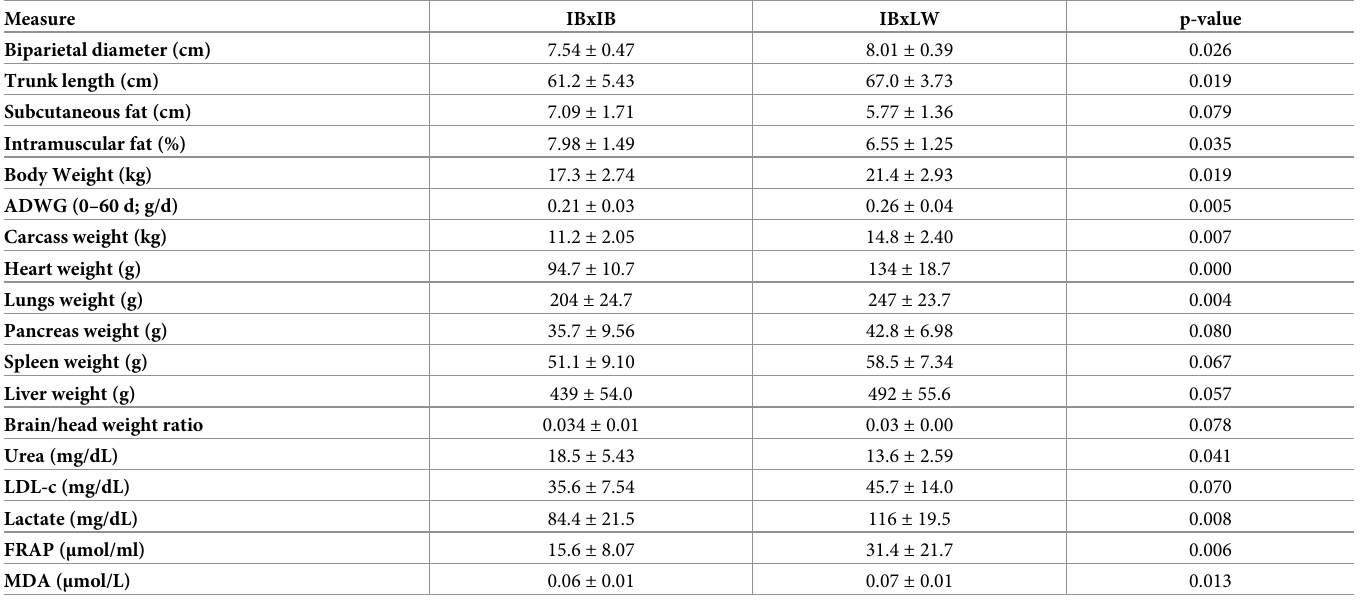
Table 1. Most important phenotypic differences (mean ± S.E.M.) between 60 days-old pure Iberian piglets (IBxIB) and Iberian x Large White crossbreds (IBxLW) selected for the present study from the ones analysed in the previous study [24].